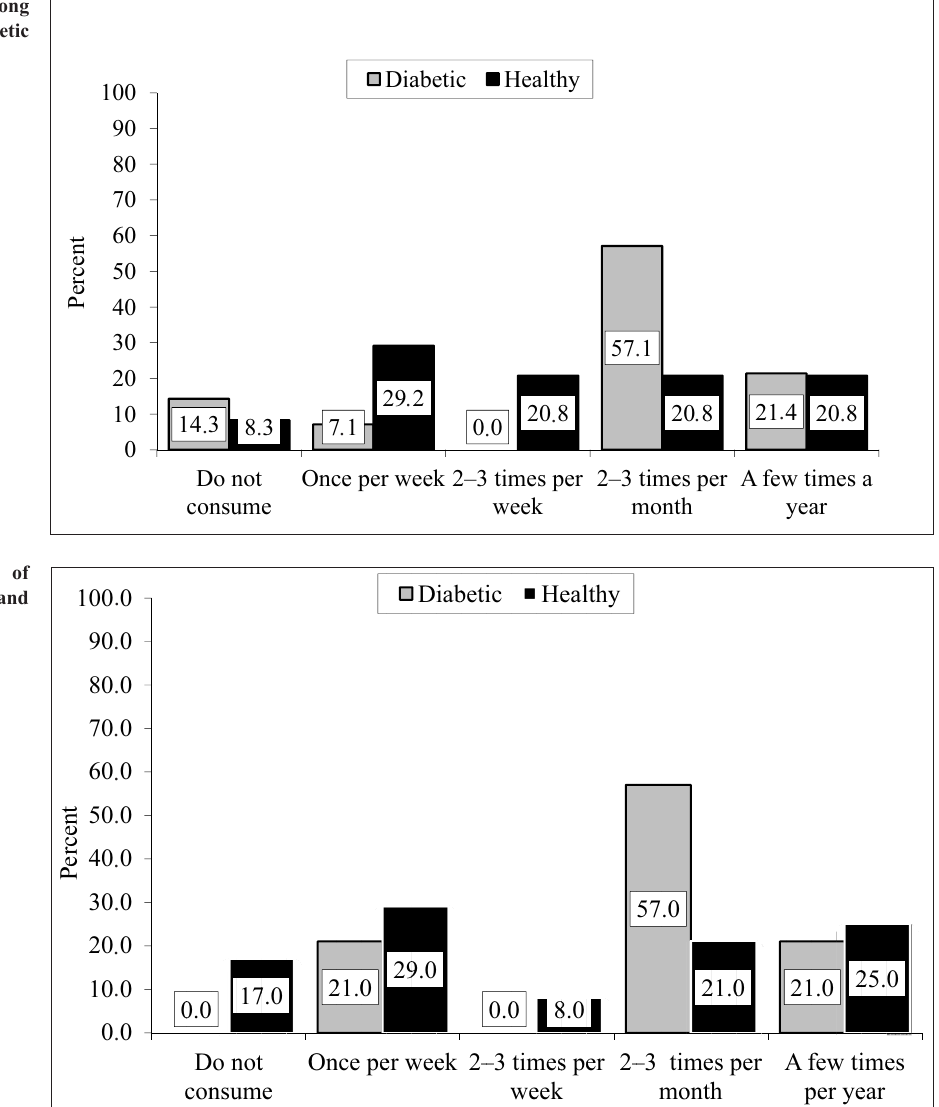
Figure 7. Frequency of strong alcohol beverages in diabetic and control groups